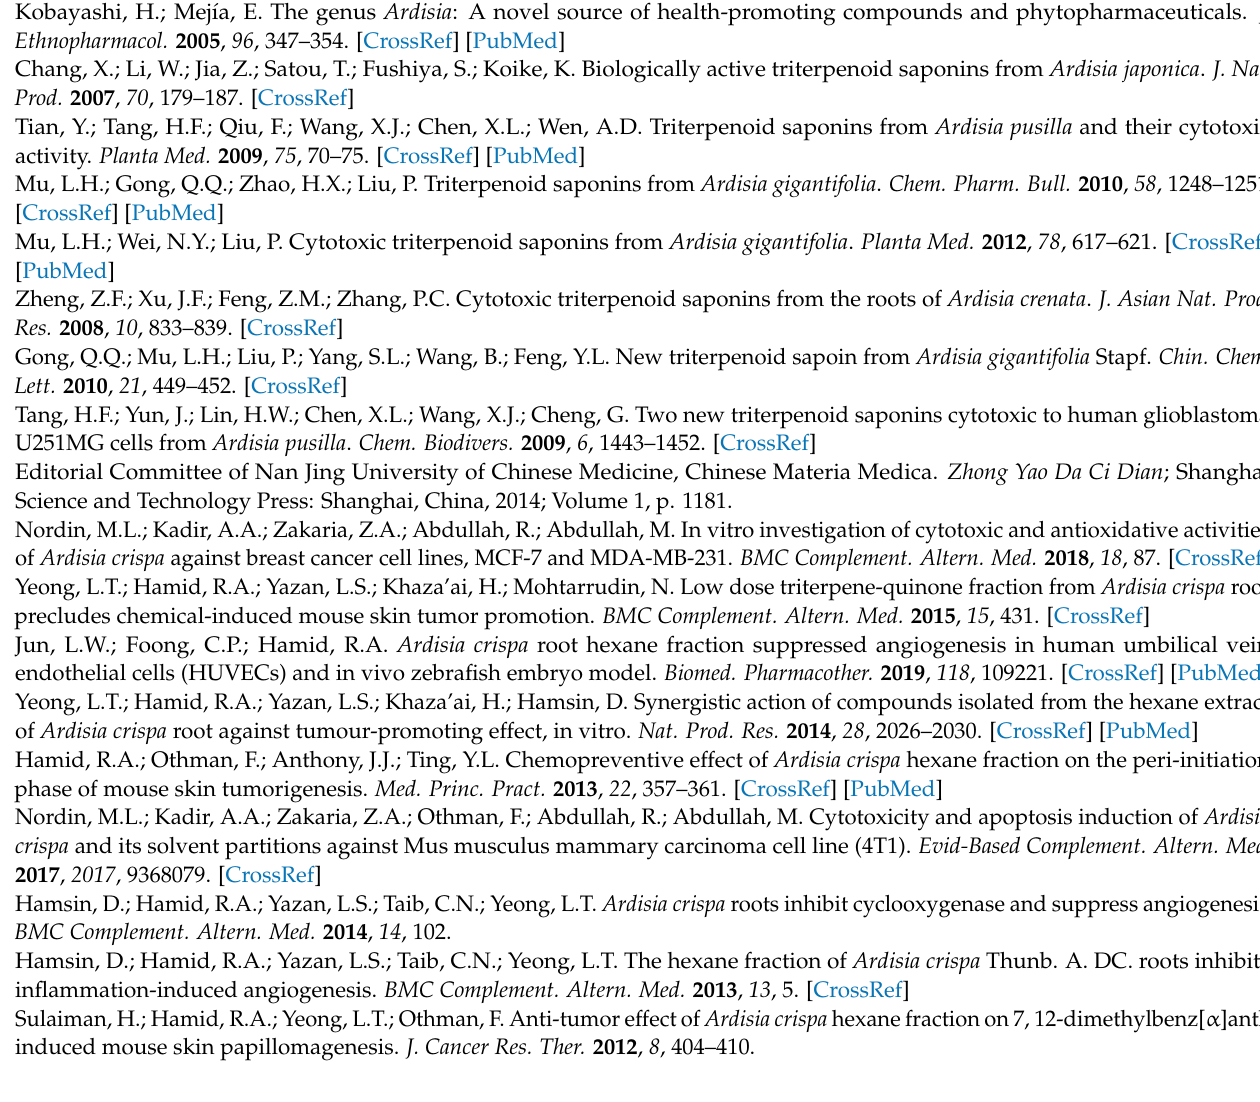
as Supporting Information. Table S1: 13 C-NMR (100 MHz) Data of 4 - 7 in CD 3